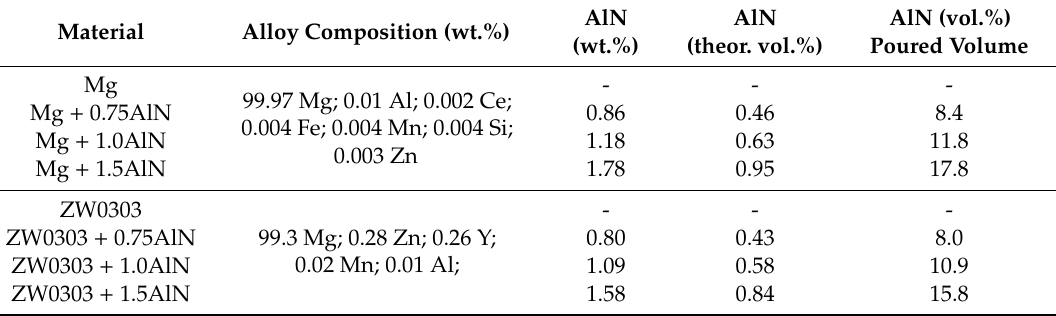
Table 1. Sample labelling and content of AlN in the